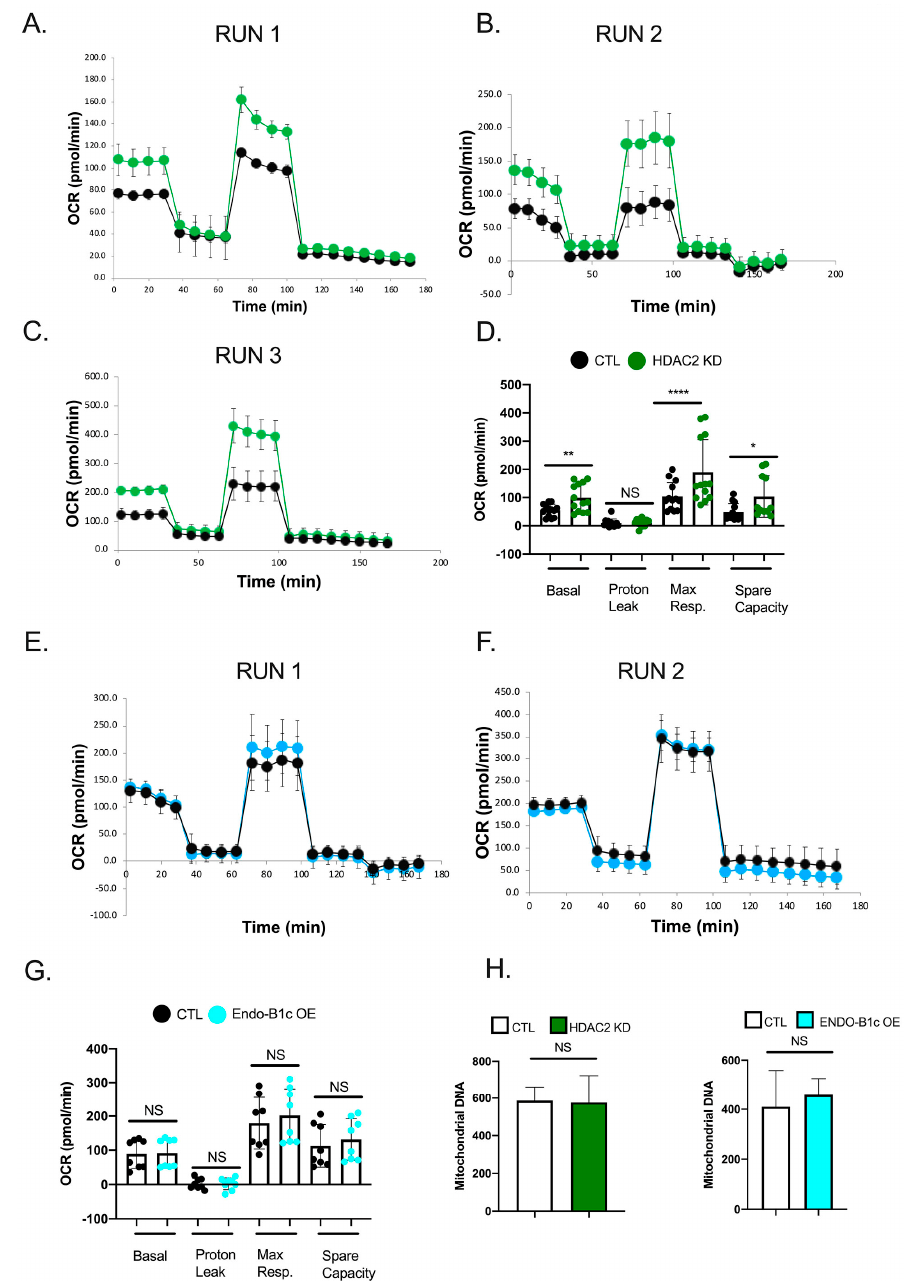
Figure 7. HDAC2 KD but not OE of EndophilinB1-c improves mitochondrial respiration in hiPSC-derived neurons. ( A – C ). Plots of individual Seahorse assays measuring the oxygen consumption rate (OCR) of hiPSC-Ns with HDAC2 KD compared to a control virus. ( D ). Compilation of the three independent Seahorse assays (shown in A – C ) shows significant increases in basal respiration, maximum respiration (Max resp.), and spare capacity. Each dot represents a technical replicate within each independent assay and data are analyzed using a one-way ANOVA with Tukey post hoc multiple comparisons; * p < 0.05; ** p < 0.01; **** p < 0.0001. ( E , F ). Plots of individual Seahorse assays of hiPSC-Ns with EndoB1-c overexpression compared to a control virus. ( G ). Compilation of the two independent Seahorse assays (shown in E , F ) shows no significant changes in basal respiration, maximum respiration (Max resp.), proton leak, or spare capacity. Each dot represents a technical replicate within each independent assay and data are analyzed using a one-way ANOVA with Tukey post hoc multiple comparisons; NS = non-significant. ( H ). Analysis of mitochondrial DNA copy number in hiPSC-Ns with HDAC2 KD or Endo-B1c OE. No significant difference was found in mitochondrial copy number in either condition when compared to a control virus. NS = non-significant by t